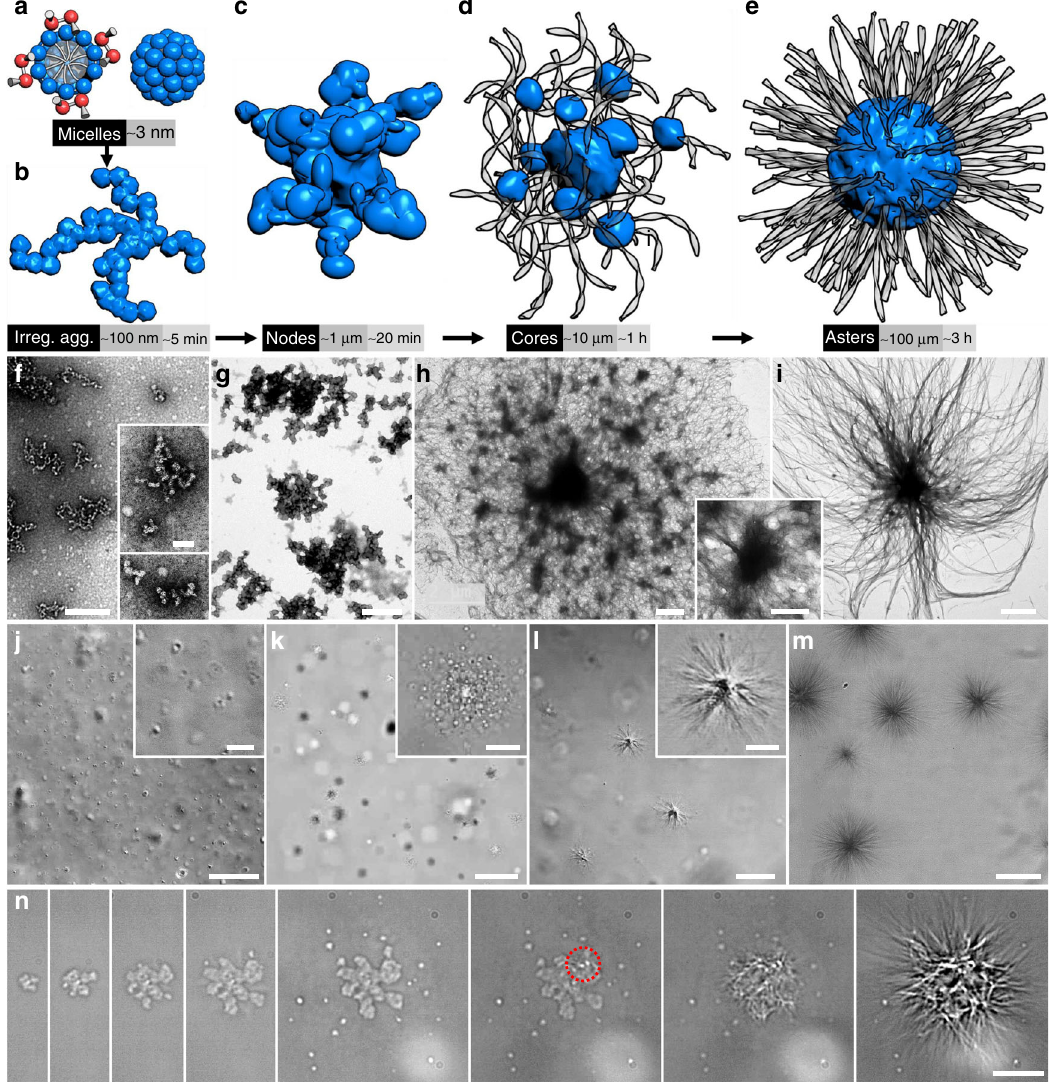
Fig. 3 Formation kinetics of the asters. a – e Schematic illustrations of aster formation with a distinct separation of length and time scales. f – i Ex situ TEM observations of the irregular aggregates ( f ), nodes ( g ), cores ( h ), and asters ( i ). j – m In situ OM observations of the nodes ( j ), cores ( k , interconnecting ribbons are unresolvable at this stage), asters ( l , m ). n Real-time formation of a single aster on glass surface, where fi brilization is initiated inside the red circle. Scale bars = 200 nm ( f ), 50 nm ( f , inset), 500 nm ( g ), 1 μ m ( h ), 500 nm ( h , inset), 5 μ m ( i ), 20 μ m ( j ), 3 μ m ( j , inset), 30 μ m ( k ), 3 μ m ( k ,